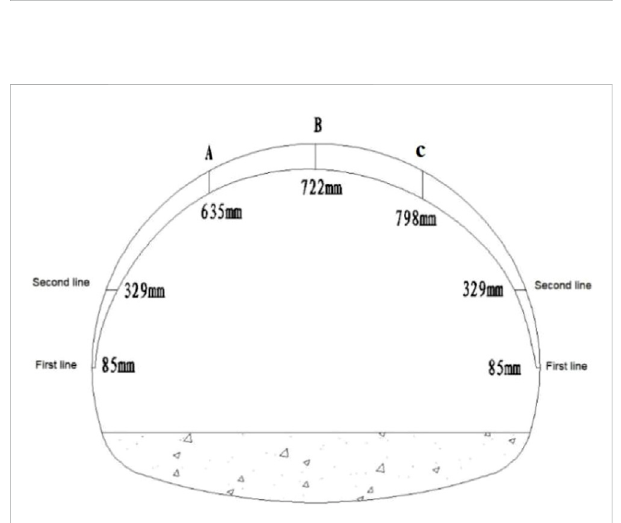
FIGURE 11 Deformation diagram of the surrounding rock at Cross-section ZK330+910.